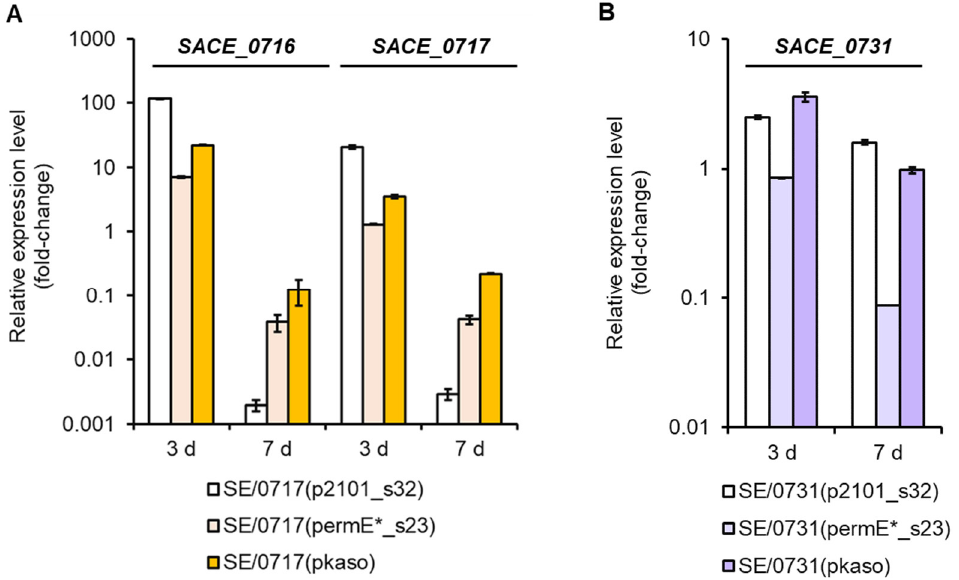
Figure 4. Relative expression levels of the target genes SACE_0716 , SACE_0717 ( A ), and SACE_0731 ( B ) on day 3 and day 7 in the engineered strains harboring three heterologous promoters p 2101_s32 , p ermE*_s23 , and p kasO compared to the wild-type strain S. erythraea NRRL 23338. The vertical axis was the logarithmic axis . Error bars represented the standard errors of the means ( n = 3).